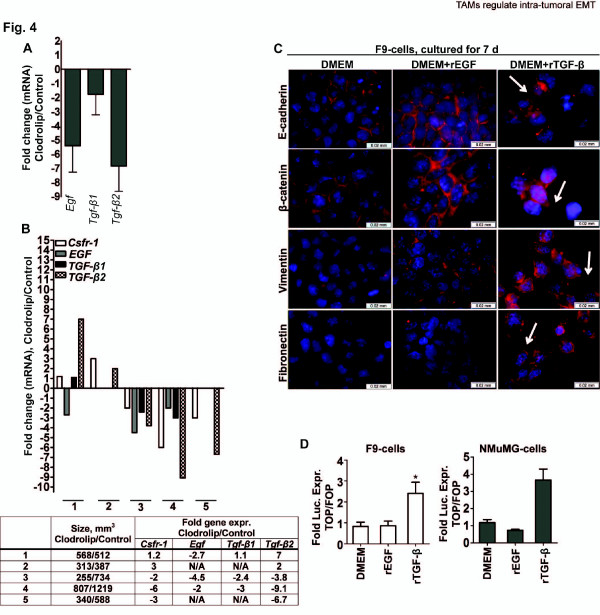
TGF-β induces trans-differentiation in F9-and NMuMG-cells in vitro. (A) Relative gene expression (mRNA levels) of Egf, Tgf-β1 and Tgf-β2 in clodrolip treated vs. control tumors; n = 5-6, bars: means ± SEM. (B) Relative gene expression (mRNA levels) of Csfr-1, Egf, Tgf-β1, and Tgf-β2 in size matched clodrolip treated vs. control tumors; n = 5-6, bars: means ± SEM. The table shows individual volumes and gene expression levels of paired treated vs. control tumors. The tumors analyzed in this figure were collected from a single depletion experiment. (C) Immunofluorescence of E-cadherin, β-catenin, vimentin and fibronectin expression and cellular localization in F9-cells cultured in DMEM +/-EGF (50 ng/ml) and +/- TGF-β1 (2 ng/ml) for 7d. Pictures of NMuMG-cells are shown in Additional file 2: Figure S4. Scale bar = 0.02 mm. Proteins are colored red and nuclei were stained with DAPI (blue). Arrows indicate the location of the annotated protein in cells cultured in DMEM + rTGF-β1, 7d. (D) Relative luciferase expression (TOPFLASH/FOPFLASH) in F9-cells (left) and NMuMG-cells (right) after 7d or 13d of culture, in DMEM ± rEGF (50 ng/ml) or rTGF-β1 (2 ng/ml), respectively.